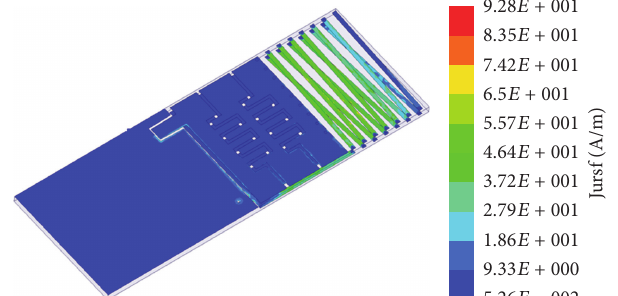
Figure 6: Simulated current distributions of the proposed antenna at 433 MHz.